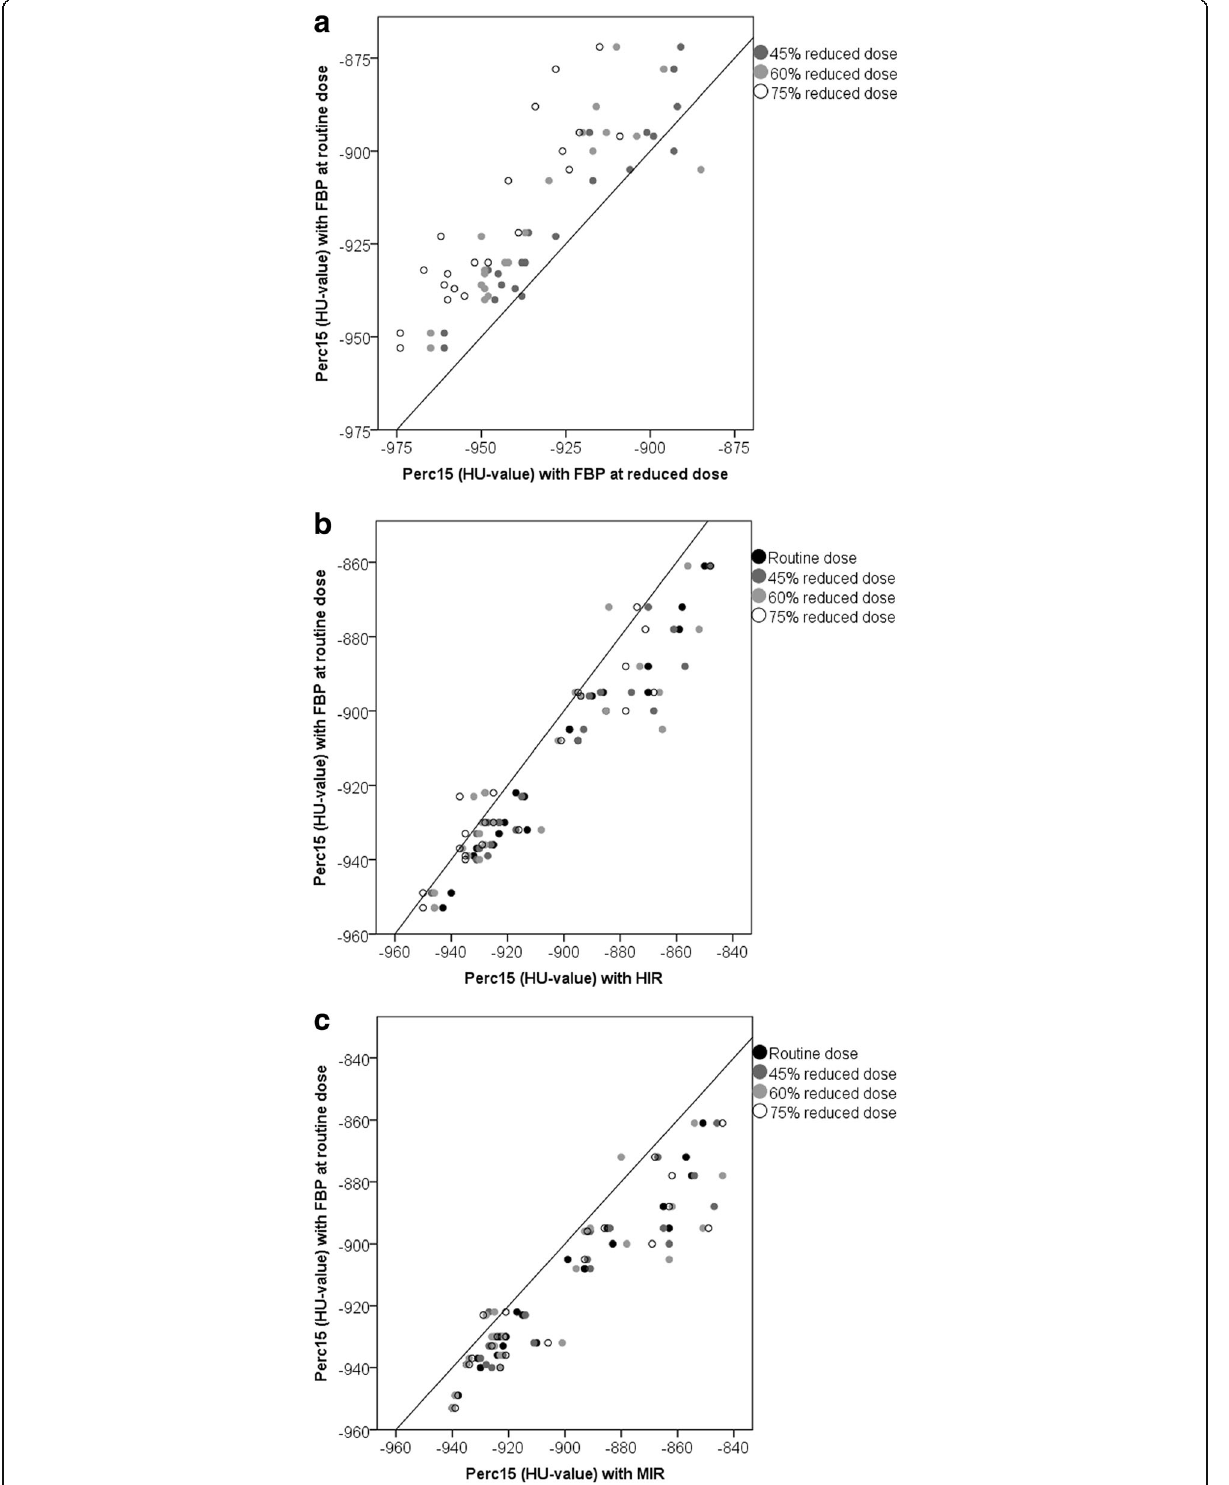
Fig. 3 Scatterplots of the effect of radiation dose and reconstruction on the perc 15 . The y-axis displays the perc 15 with FBP at routine dose (reference), while the x-axis displays the perc 15 at reduced dose with FBP ( a ) and with HIR ( b ) and MIR ( c ). Values below the diagonal represent a higher HU value compared to the reference, while values above the diagonal represent a lower HU value compared to the reference. FBP filtered back projection, HIR hybrid iterative reconstruction, MIR model-based iterative